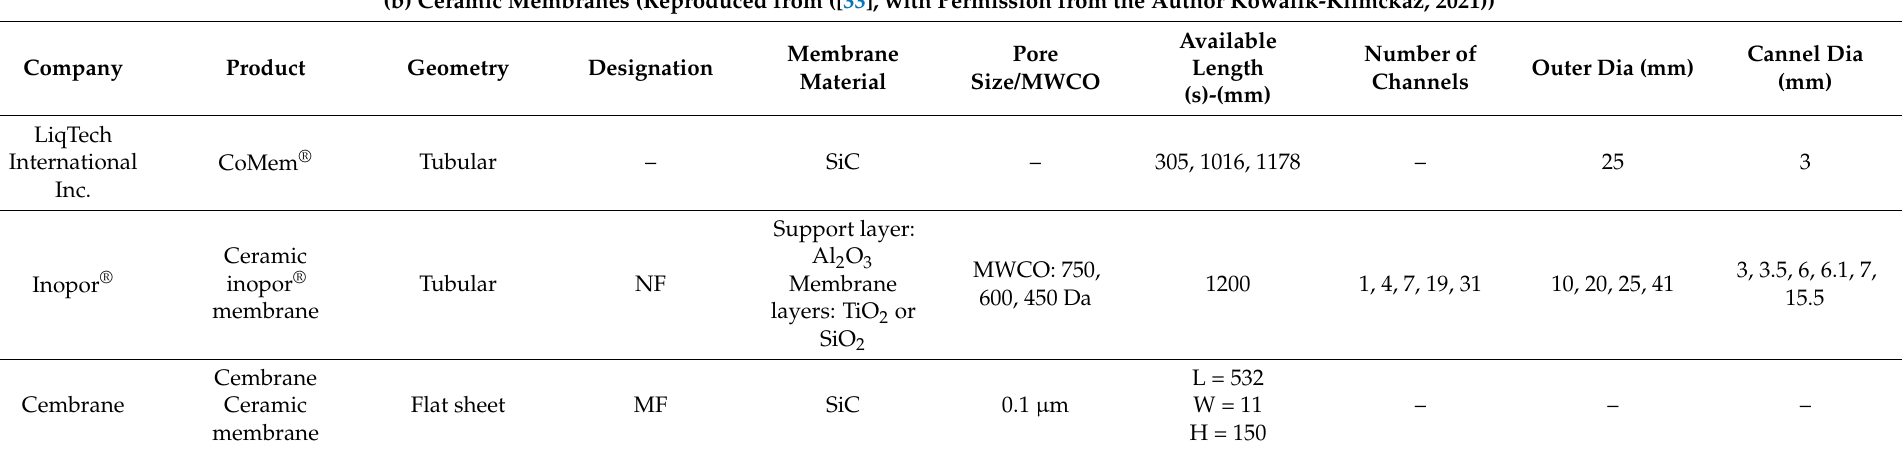
(b) Ceramic Membranes (Reproduced from ([33], with Permission from the Author Kowalik-Klimckaz,